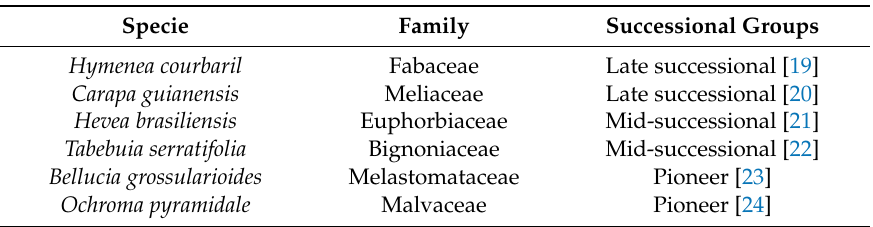
Table 1. List of studied species with scientific name, family, and successional groups, as described in literature.